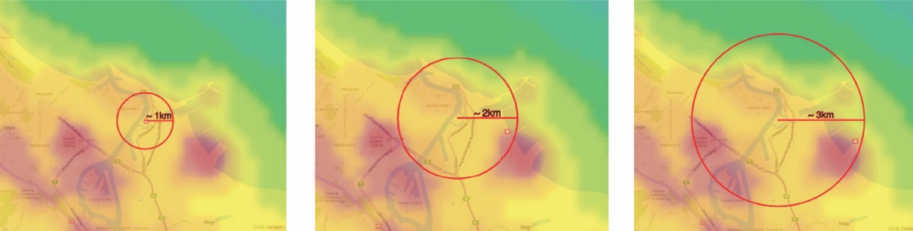
Figure 13. Area enclosed by a circle with a 1 km, 2 km, and 3 km radius. Source: authors’ elaboration based on the graphics displayed by the LPM service.